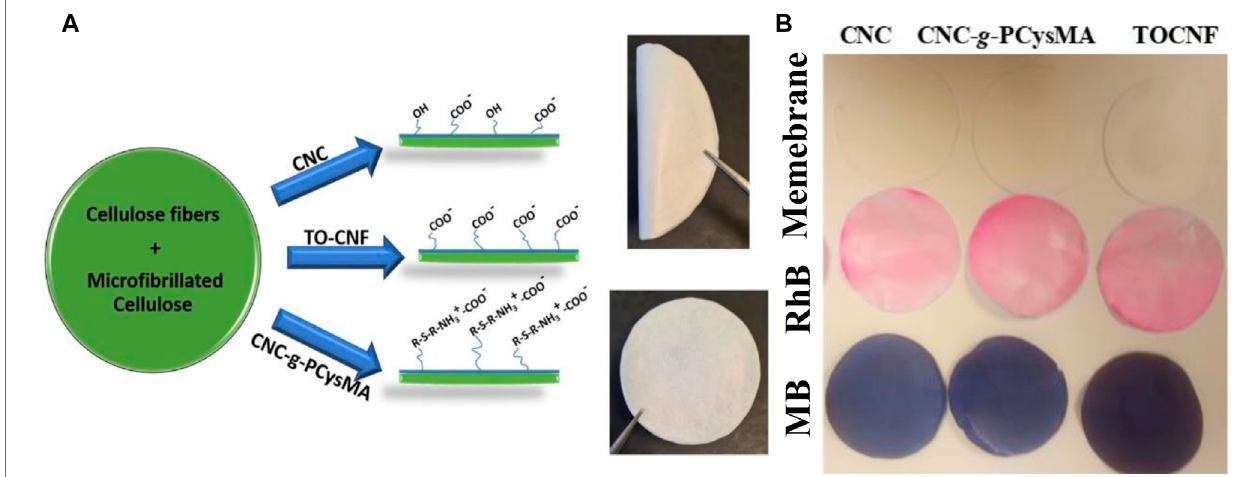
FIGURE7|(A) Schematicrepresentationforthesynthesisofall-cellulosemembranes,andphotographsofCNCmembranes(51 mmdiameter)thatcanbe fl ipped and (B) the membrane before and after adsorption of organic dyes, RhB and MB. Figure reprinted from Ref (Georgouvelas et al., 2021). This Open Access Article is